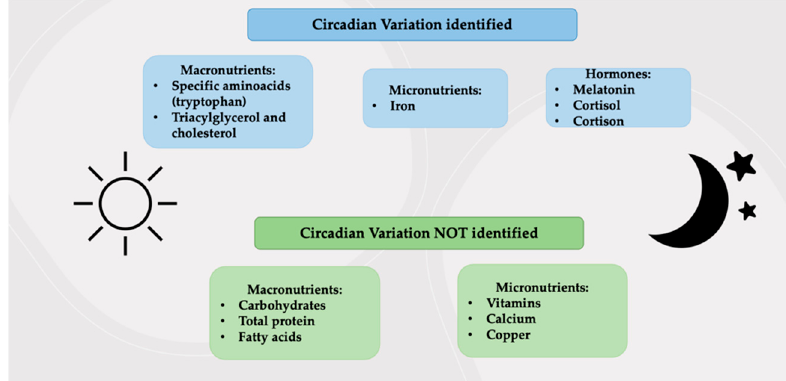
Figure 3. Components of breast milk affected or not by the circadian variation.